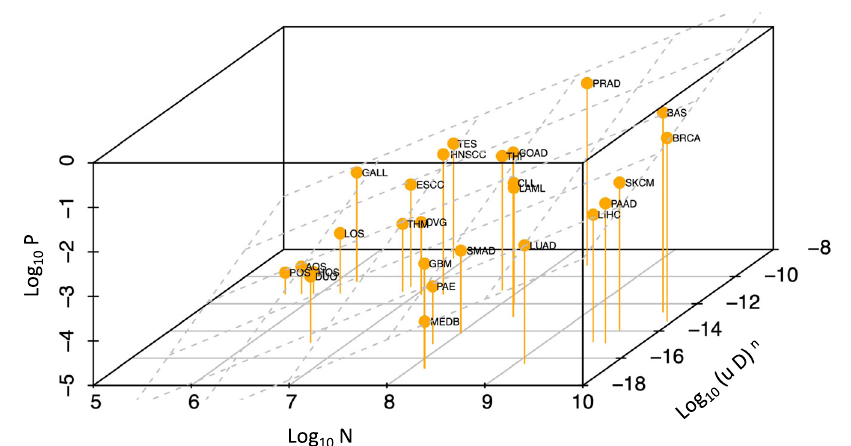
number of required driver mutations. The plane corresponds to the 3D linear regression surface. See Table 2 for the meaning of the abbreviations. Source data are provided as a Source Data fi le.